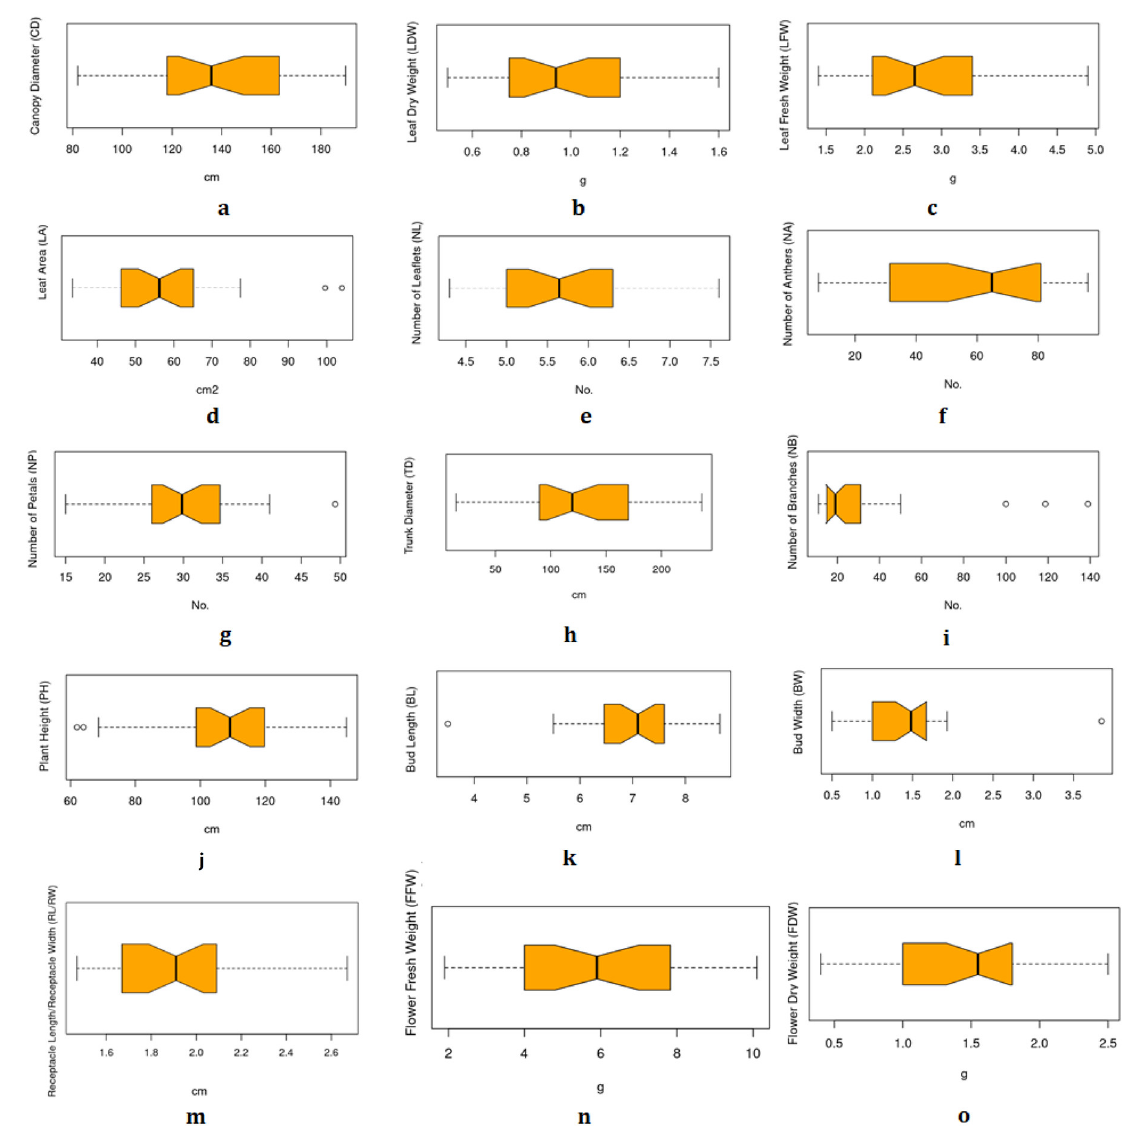
Figure 3. Boxplot of the phenotyping dataset: ( a ) Canopy diameter (CD), ( b ) leaf dry weight (LFW), ( c ) leaf fresh weight (LFW), ( d ) leaf area (LA), ( e ) number of leaflets (NL), ( f ) number of anthers (NA), ( g ) number of petals (NP), ( h ) trunk diameter (TD), ( i ) number of branches (NB), ( j ) plant height (PH), ( k ) bud length (BL), ( l ) bud width (BW), ( m ) receptacle length/receptacle width (RL/RW), ( n ) flower fresh weight (FFW) and ( o ) flower dry weight (FDW). Units of measurements are: cm (CD, TD, PH, BL, BW, RL/RW); g (LDW, LFW, FFW, FDW); No. (NL, NA, NP, NB) and cm 2